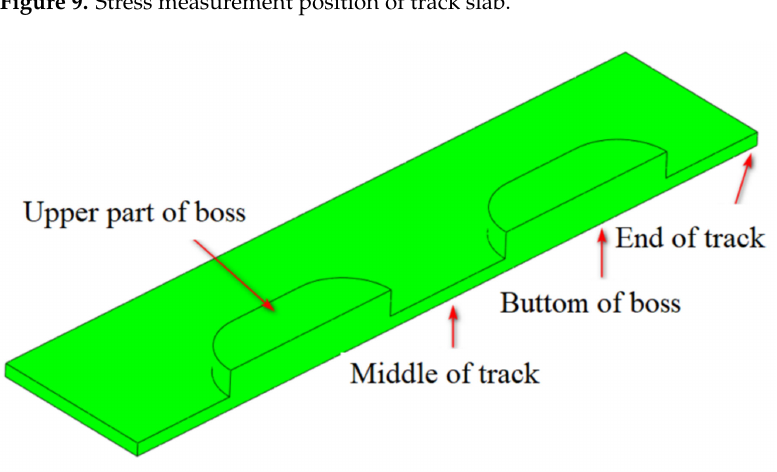
Figure 9. Stress measurement position of track slab.